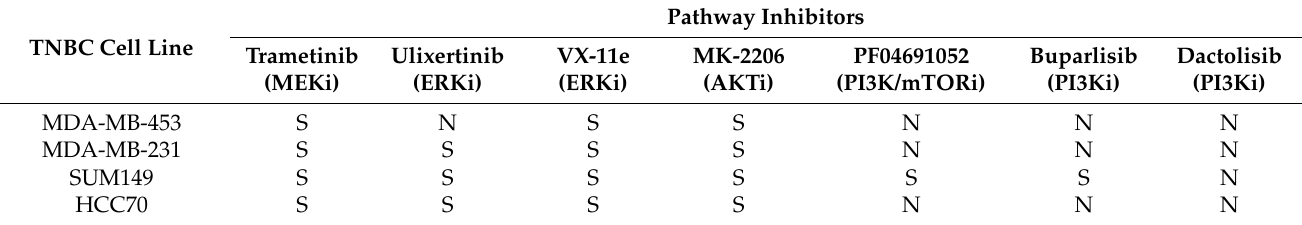
Table 3. Synergistic antitumor effect of ONC201 in combination with MAPK and PI3K pathway inhibitors.